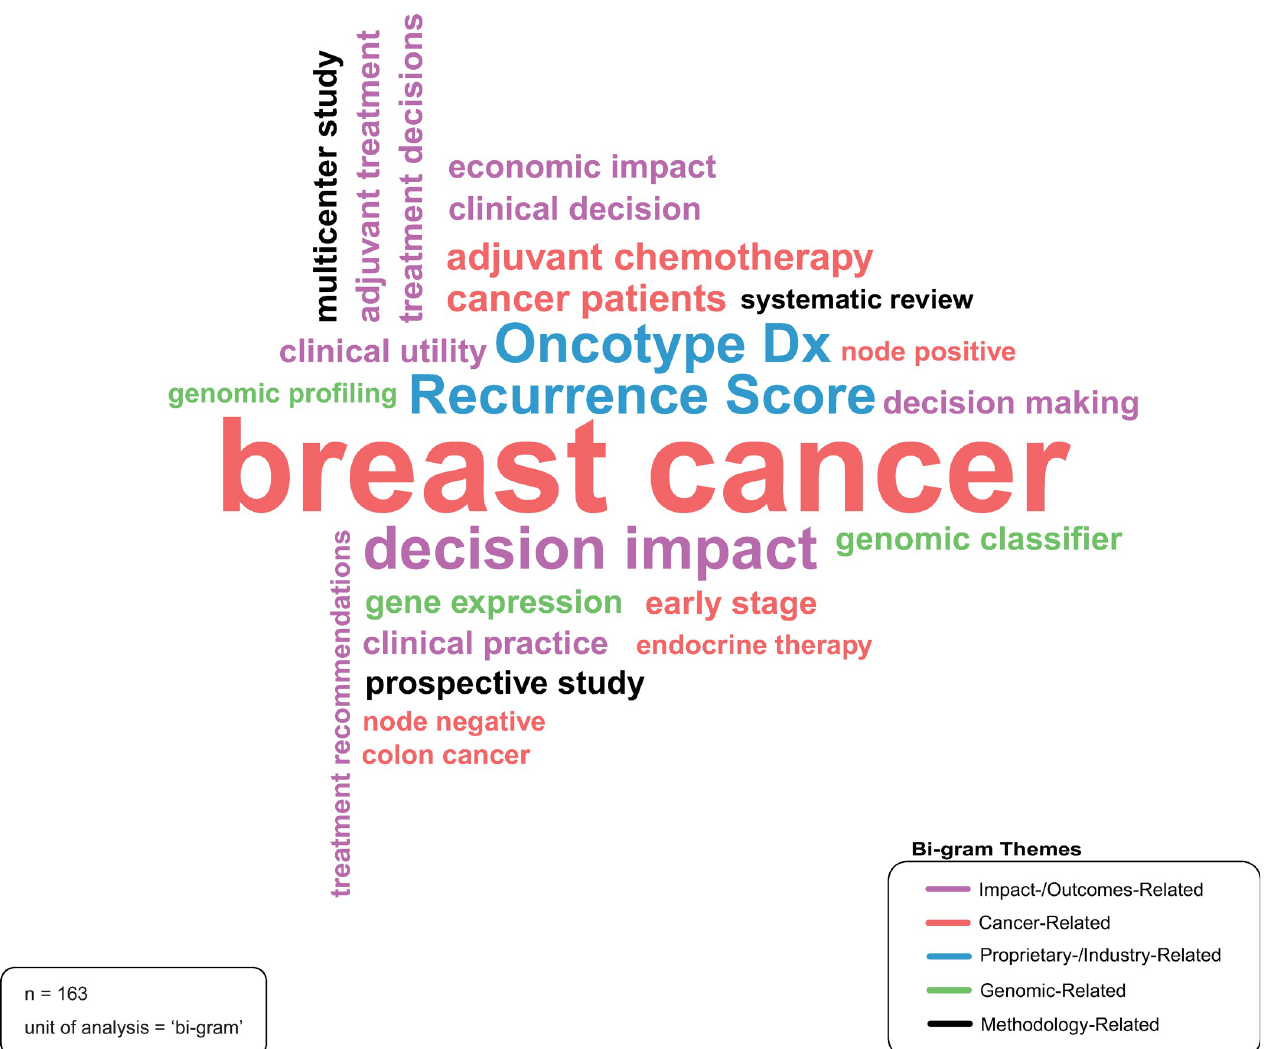
Fig 3. Title topics. Source: R-based application ‘wordcloud’ was used to generate the word cloud; additional analysis (i.e., categorization of the bi-grams) was completed by the study authors and applied to the visualization using Adobe Illustrator. Parameters specified: n-gram-type (phrase-length) = ‘bi-grams’; minimum n-gram frequency =